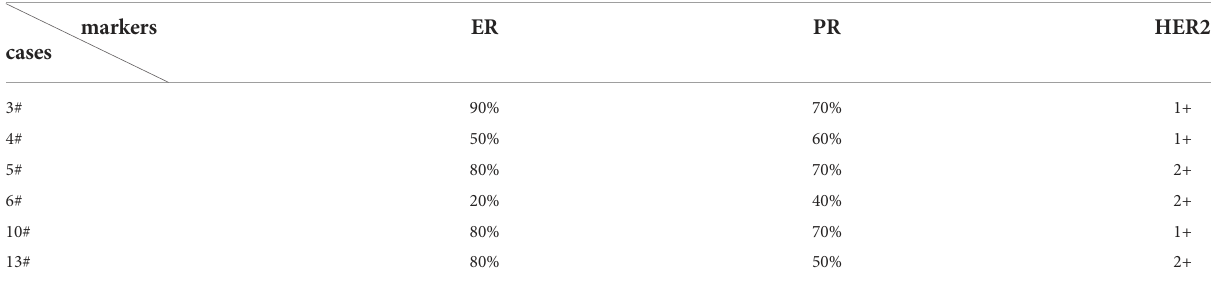
TABLE 2 The expression of molecular markers in 6 Cases of Patients with Breast Cancer.